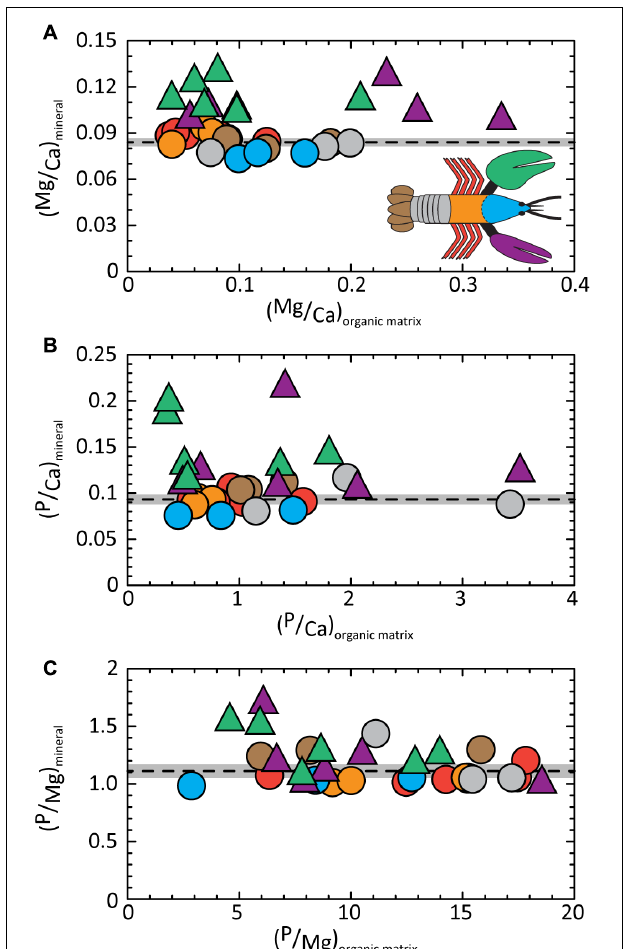
FIGURE 4 | Molar ratios of elements contained in the mineral fraction of exoskeleton body parts are conserved relative to the wide range of ratios determined for the corresponding organic fraction. Dashed lines give average values of (A) (Mg/Ca) mineral = 0.084 ± 0.001; (B) (P/Ca) mineral = 0.093 ± 0.003; and (C) (P/Mg) mineral = 1.110 ± 0.030. Gray bands illustrate the 2 σ standard error (95% confidence interval). Detailed statistics are given in Supplementary Tables S1, S3